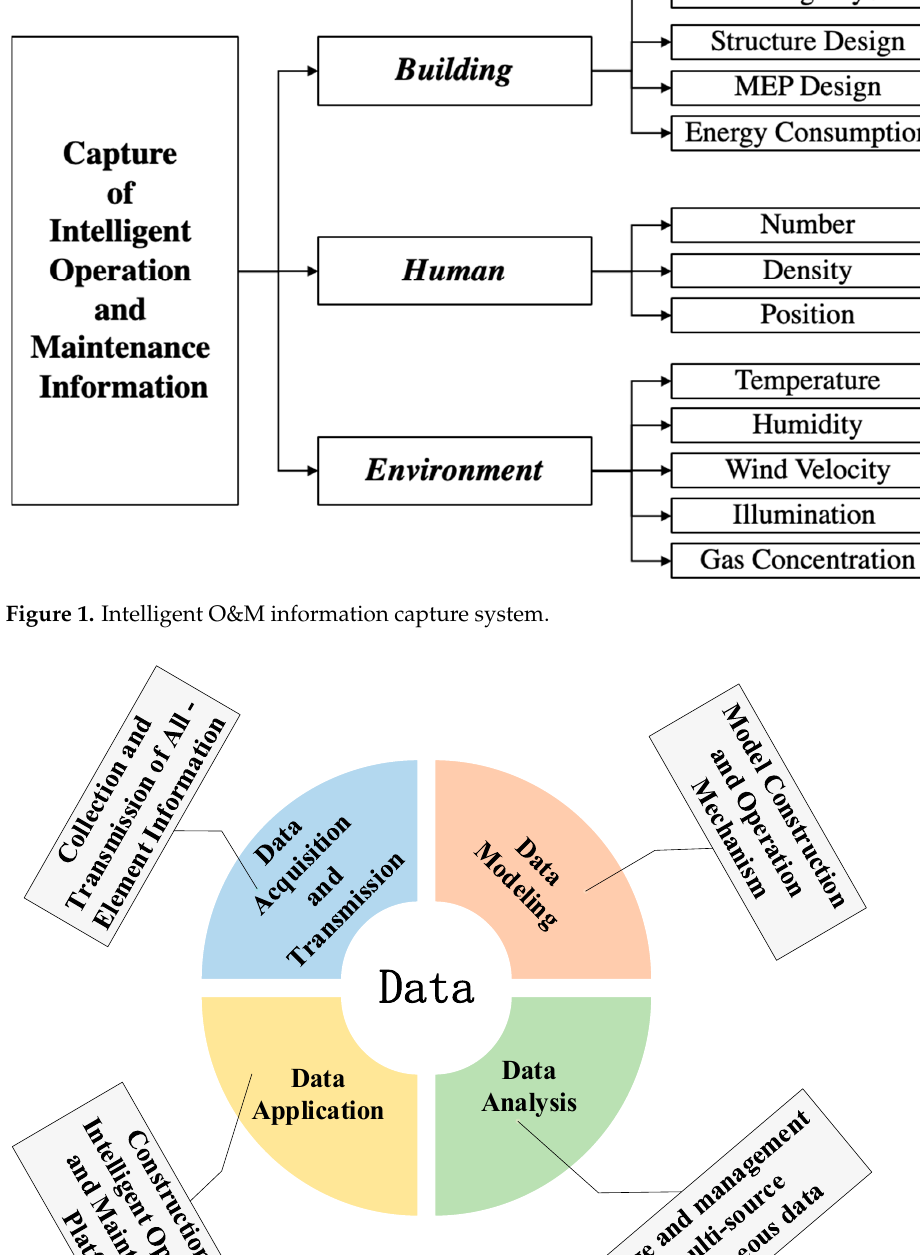
Figure 1. Intelligent O&M information capture system.